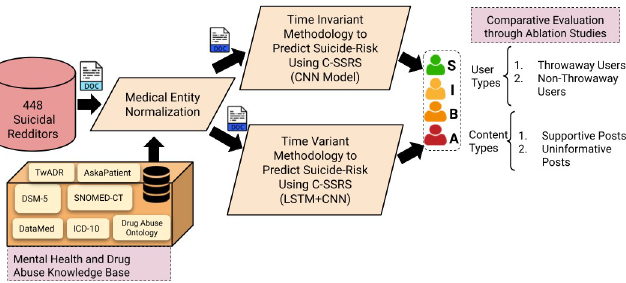
Fig 2. An overall pipeline of our comparative study to predict suicide-risk of an individual using the C-SSRS and Diagnositic Statistical Manual for Mental Health Disorders (DSM-5). S: Supportive, I: Suicide Ideation, B: Suicide Behavior, A: Suicide Attempt